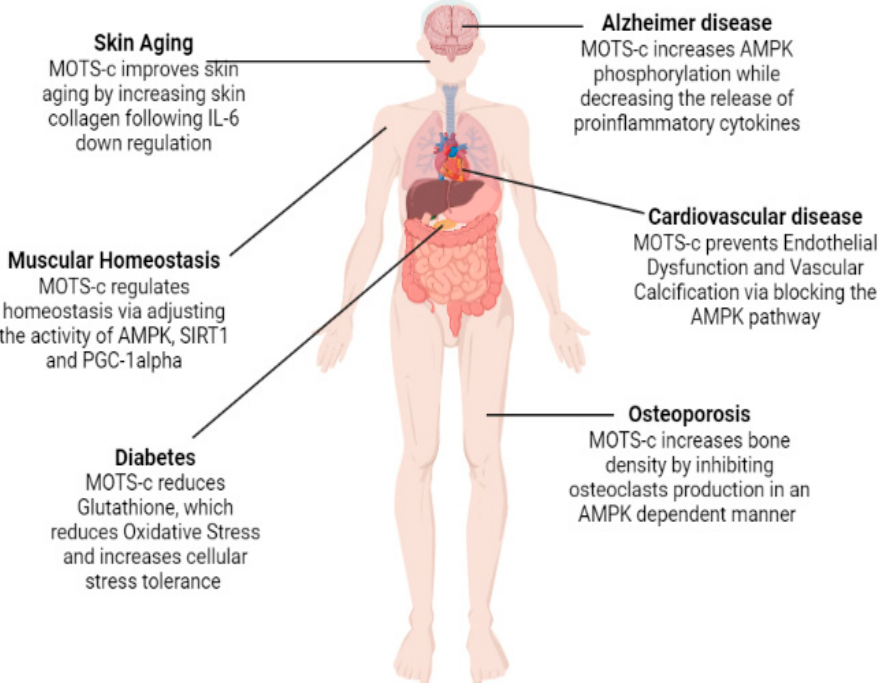
Figure 4. Role of MOTS-c in relation to different age-related disorders .